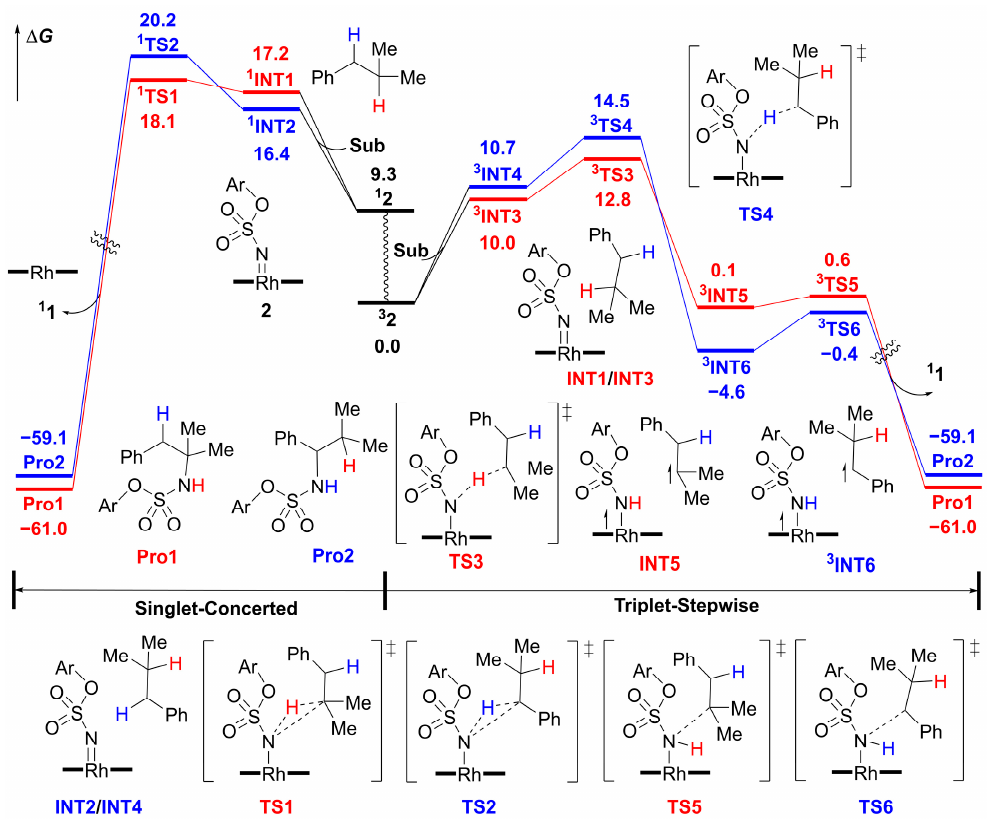
Figure 5. Free energy profiles of Rh 2 ( S − tfpttl) 4 − catalyzed intermolecular C–H aminations. Free energy obtained at the ONIOM(M06/def2 − TZVP:UFF//BPW91/6 − 31G* − LANL2DZ:UFF) level. Energies are shown in kcal mol − 1 . Ar = p − tert − butylphenyl.